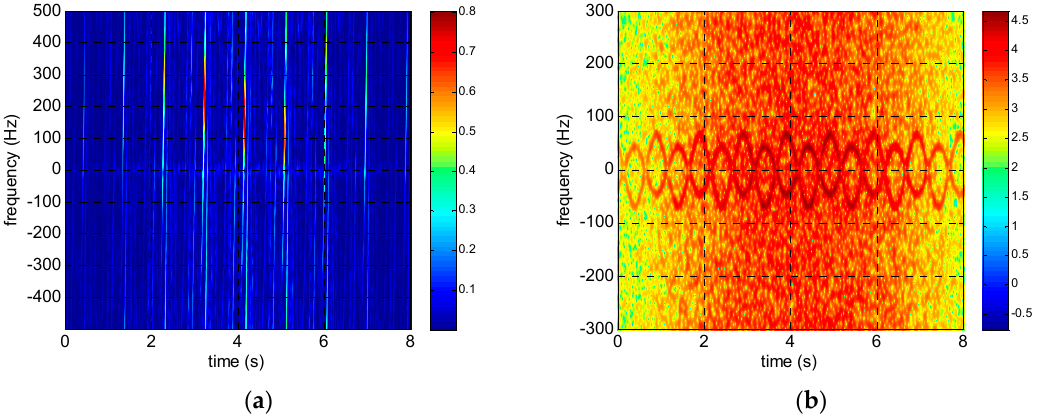
Figure 7. Time–frequency distributions of corner reflectors rotating at 40 r/min ( a ) before and ( b ) after intra-pulse interference processing.